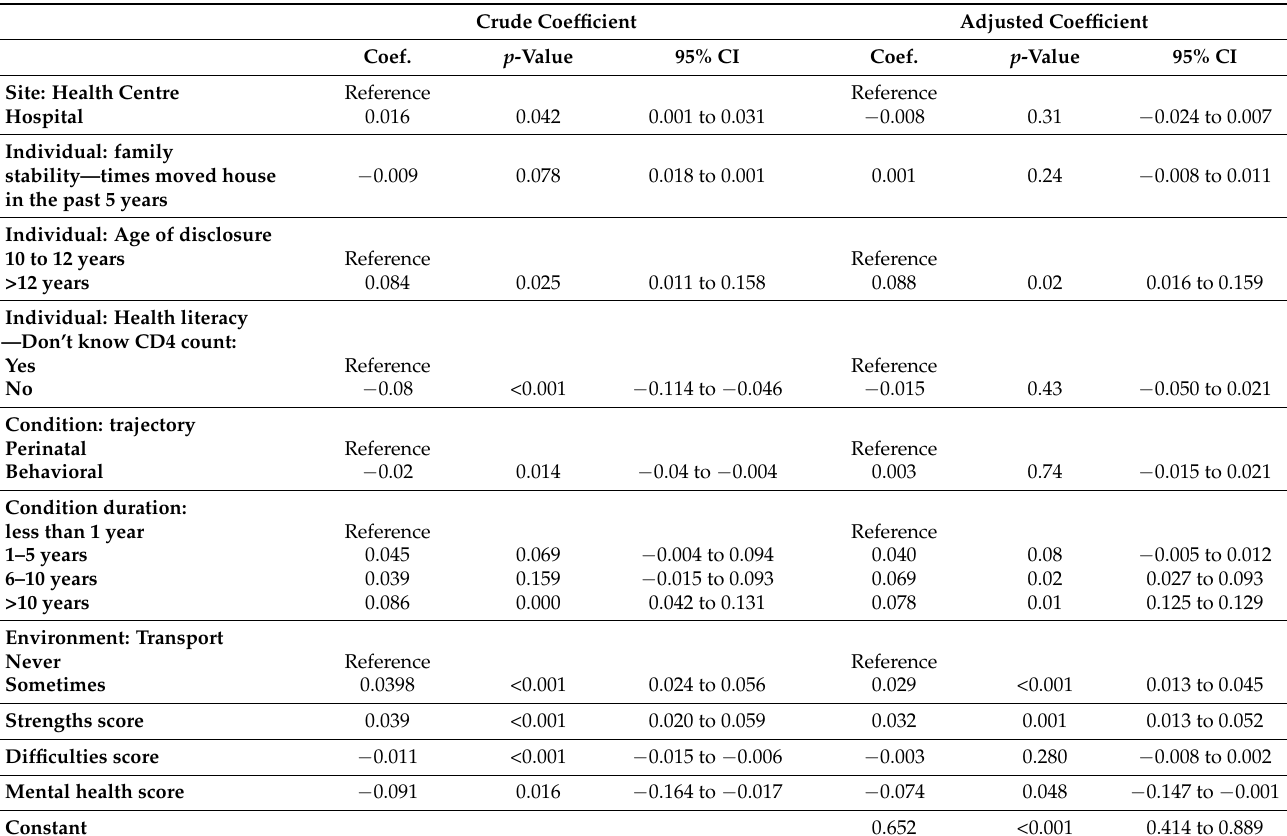
Table 6. Logistic regression analysis of self-management score on predictor